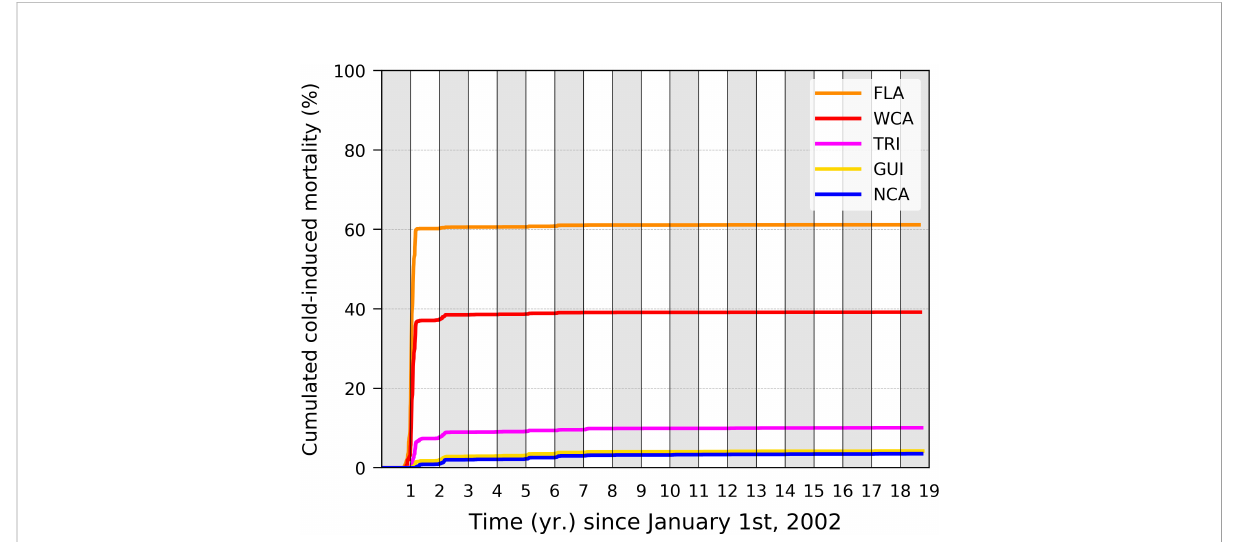
FIGURE 6 Cumulated cold-induced mortality in each of the fi ve stocks obtained with T b = 22°C. Only one departure year (2002) and one nesting beach per stock were